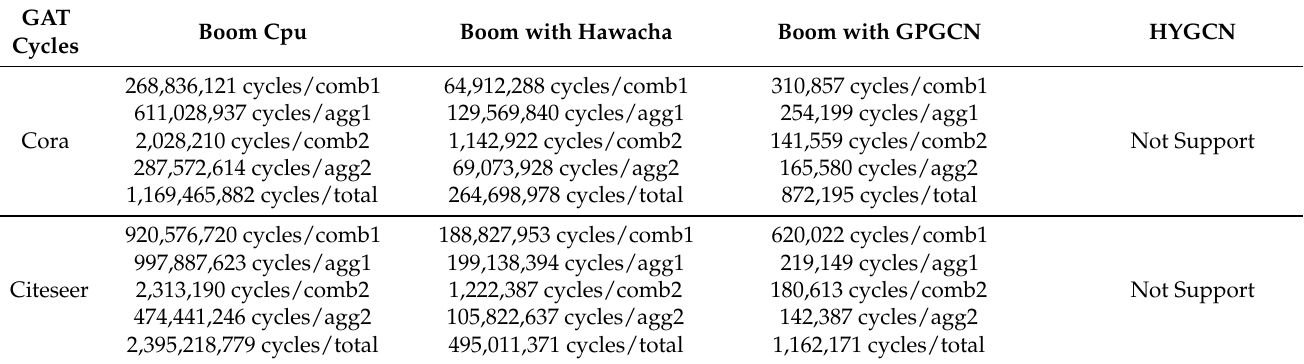
Table 10. The GAT execution latency of different hardware with different datasets.